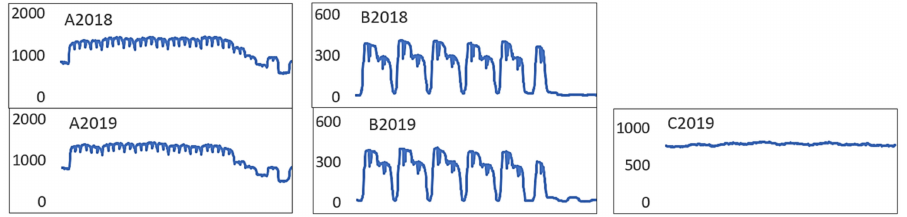
Figure 2. Comparison of average weekly power demand profiles in [kW] of one annual period. The successive values on the horizontal axes correspond to the consecutive 15-min intervals for all days of the week. Power values (vertical axes) were averaged for the